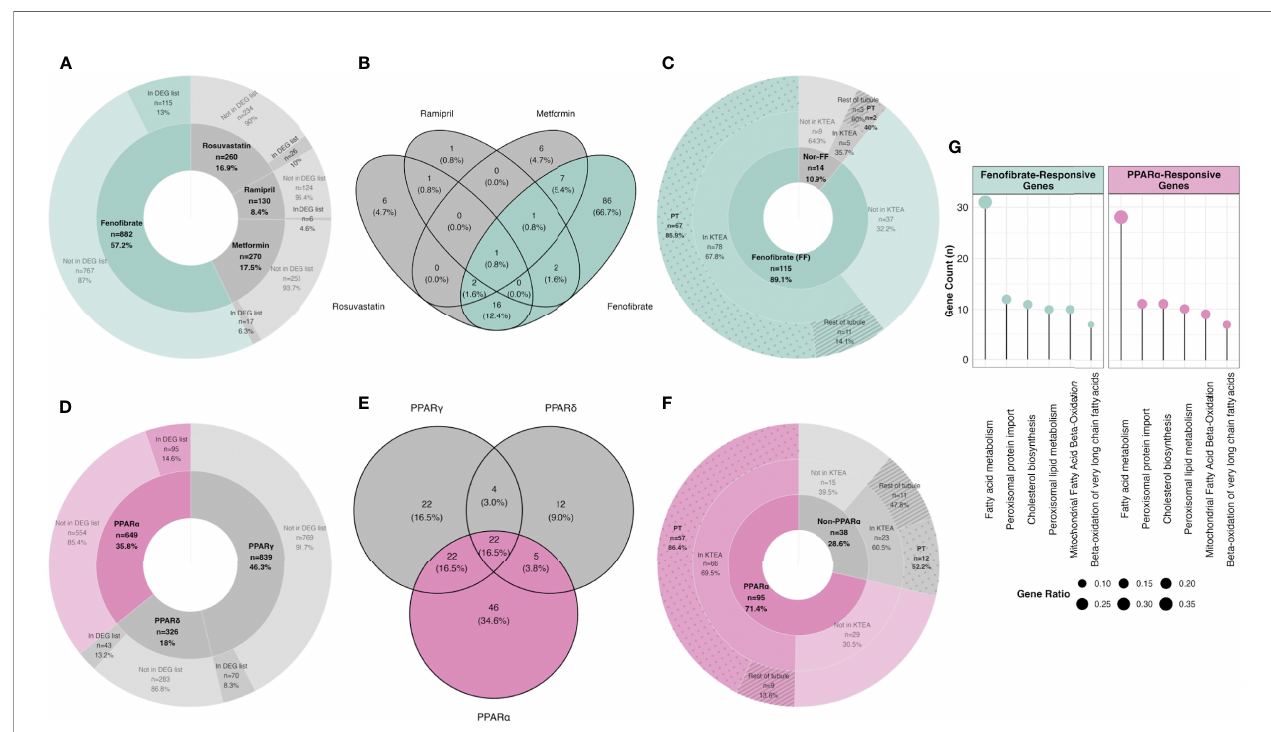
FIGURE 4 | In silico deconvolution of medication-speci fi c and PPAR isotype-speci fi c transcriptomic effects following RYGB-FMRR. (A, D) Genes responsive to FMRR medications (A) and PPAR isotypes (D) were retrieved from IPA, intersected with transcripts identi fi ed in the RYGB-FMRR versus RYGB differential expression analysis, and presented on doughnut plots with counts and percentages of transcripts in each category outlined. The inner doughnut layers outline all transcripts known to be responsive to each medication (A) or PPAR isotype (D) . The outer layers stratify transcripts by presence in or absence from the RYGB-FMRR vs RYGB DEG list. (B, E) Venn diagram enumeration of the overlap and separation in transcripts present in the RYGB-FMRR vs RYGB DEG list and responsive to one or more of the FMRR medications (B) or one or more of the PPAR isotypes (E) . These transcripts are labelled as ‘ In DEG list ’ in the outer doughnut layers in (A, D) , respectively. (C, F) Subsets of genes present in the RYGB-FMRR vs RYGB DEG list and found to be responsive to FMRR medications (C) or PPAR isotypes (F) are presented on doughnut plots with counts and percentages of transcripts in each category outlined. Transcripts are strati fi ed by feno fi brate- (C) or PPAR a - (F) responsiveness (inner layers), presence or absence from Kidney Tubules Expression Atlas (KTEA; middle layers), and localisation in either the proximal tubule or the rest of the renal tubule in KTEA (outer layers). (G) Dotplots of over-represented Reactome pathways for feno fi brate- and PPAR a -responsive genes present in the RYGB-FMRR vs RYGB DEG list. The size of dots is scaled by the gene ratio. DEG, differentially expressed gene; FF, feno fi brate; FMRR, feno fi brate, metformin, ramipril, and rosuvastatin; KTEA, Kidney Tubules Expression Atlas; PPAR, peroxisome proliferator-activated receptor; PPAR a , peroxisome proliferator-activated receptor-alpha; PPAR d , peroxisome proliferator-activated receptor-delta; PPAR g , peroxisome proliferator-activated receptor-gamma; PT, proximal tubule; RYGB, Roux-en-Y gastric bypass; RYGB-FMRR, Roux-en-Y gastric bypass plus feno fi brate, metformin, ramipril, and